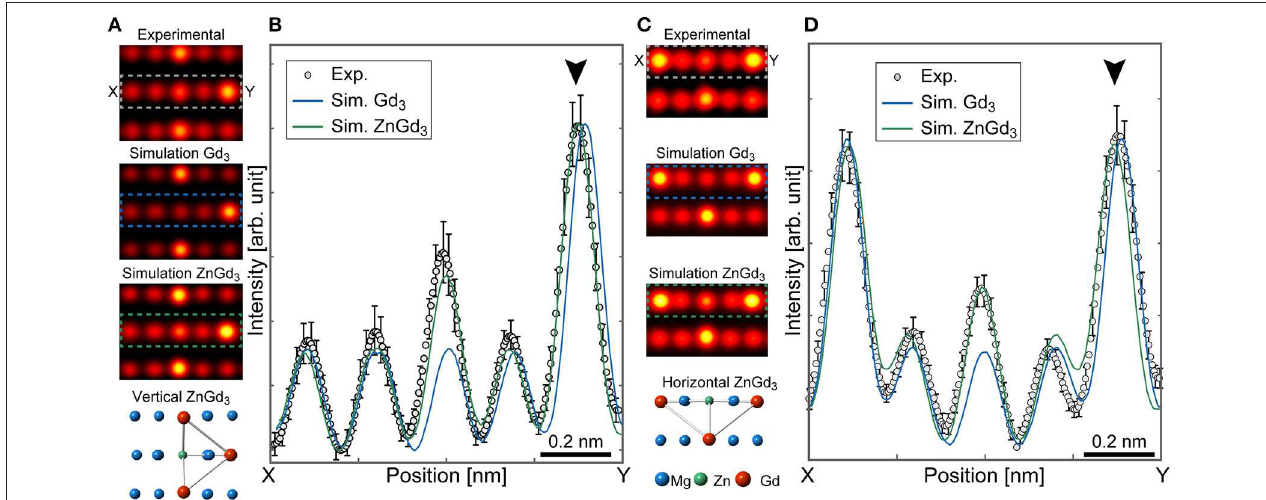
FIGURE 6 | (A) Experimental and simulated STEM images of the T V -SRO cluster. The experimental image has been reconstructed by averaging over the 26 local images in Figure 1d , by automatically selecting the similar contrast regions according to the autocorrelation search. Image simulations are performed for the T V -SRO cluster with and without Zn atom, and the T V -SRO clusters are placed at the 4nm in depth from the surface of the supercell. The conditions for simulations are the same as those described in Figure 2B . (B) Intensity profiles across X-Y in the dotted rectangles in the images in (A) . (C) Experimental and simulated STEM images of the T H -SRO cluster. The 23 local images have been extracted and used for the reconstruction of the experimental image, and the averaging procedure and the simulation conditions are the same as those described in (A) . (D) Intensity profiles across X-Y in the dotted rectangles in the images in (A) .